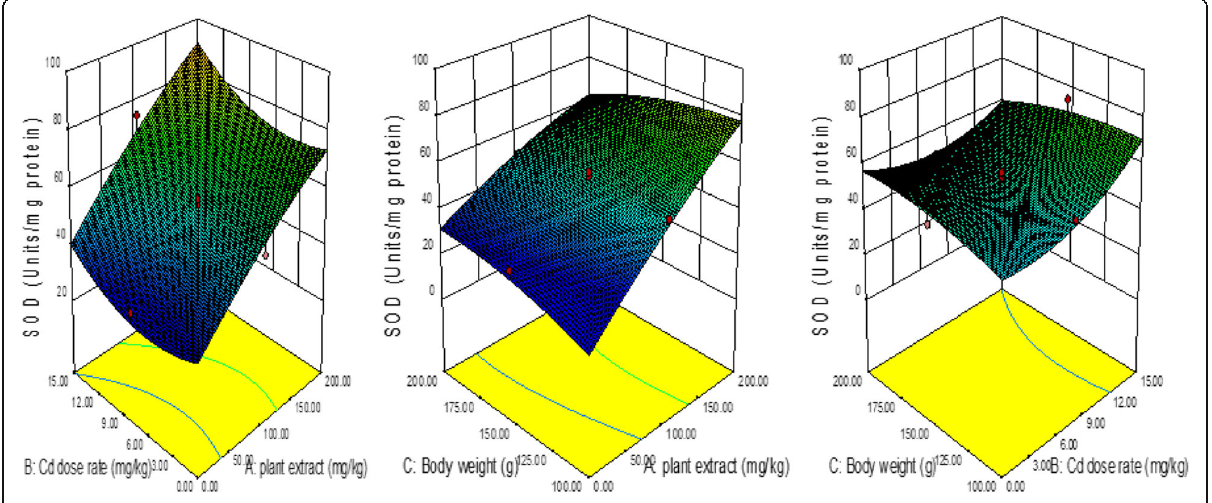
Fig. 5 3-D surface plots for serum SOD activity under the influence of process variables